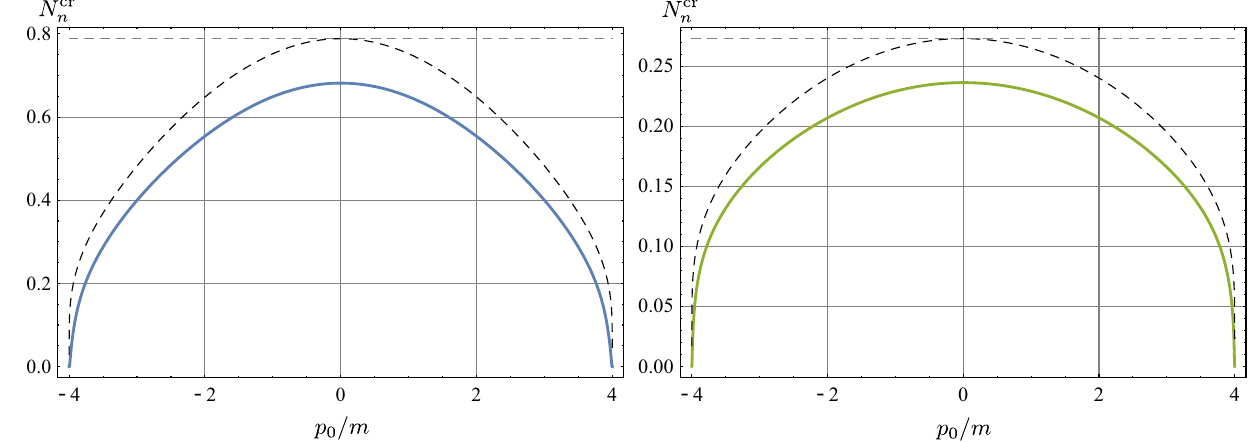
Fig. 5 Differential mean numbers of Bosons created from the vacuum N cr n by symmetrical inverse-square electric fields. The exact results (solid lines) are given by the absolute square value of Eq. (40) and the asymptotic ones (dashed curves), by Eq. (82). In the left panel, E = 250 E c and m ξ 1 = m ξ 2 = 1 / 50 while in the right panel,